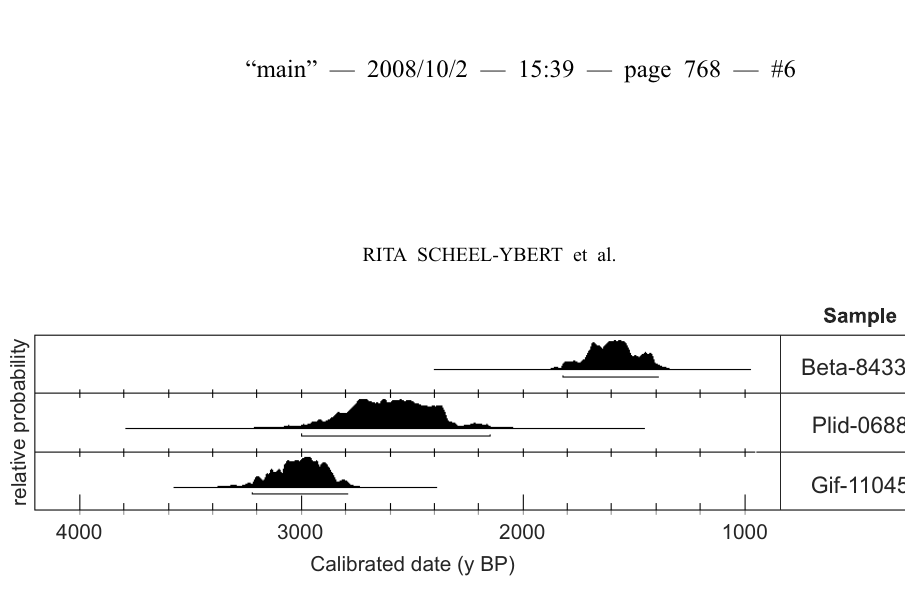
Fig. 4 – Probability distributions of calibration intervals (OxCal v3.10, Ramsey 1995) for the samples dated in this work (Gif-11045, Plid-0688) and a previously dated sample (Beta-84333, Buarque 1995). The total area under each curve is normalized to one (100%